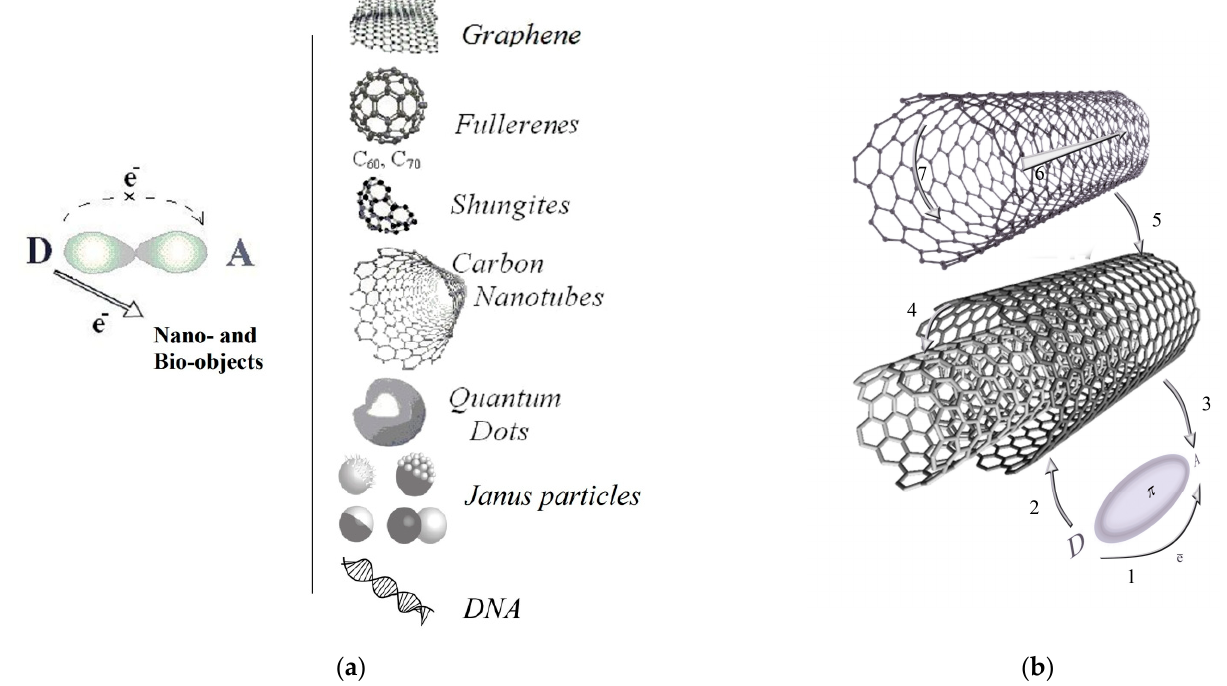
Figure 1. ( a )—Possible qualitative model, which can visualize the charge transfer pathway change for the conjugated nano- and bio-objects-doped organics under the condition when inter-molecular CTC can dominate the intra-molecular one; ( b )—Schematic diagram of possible charge transfer pathways depending on the arrangement of the introduced intermolecular acceptor relative to the intramolecular donor.